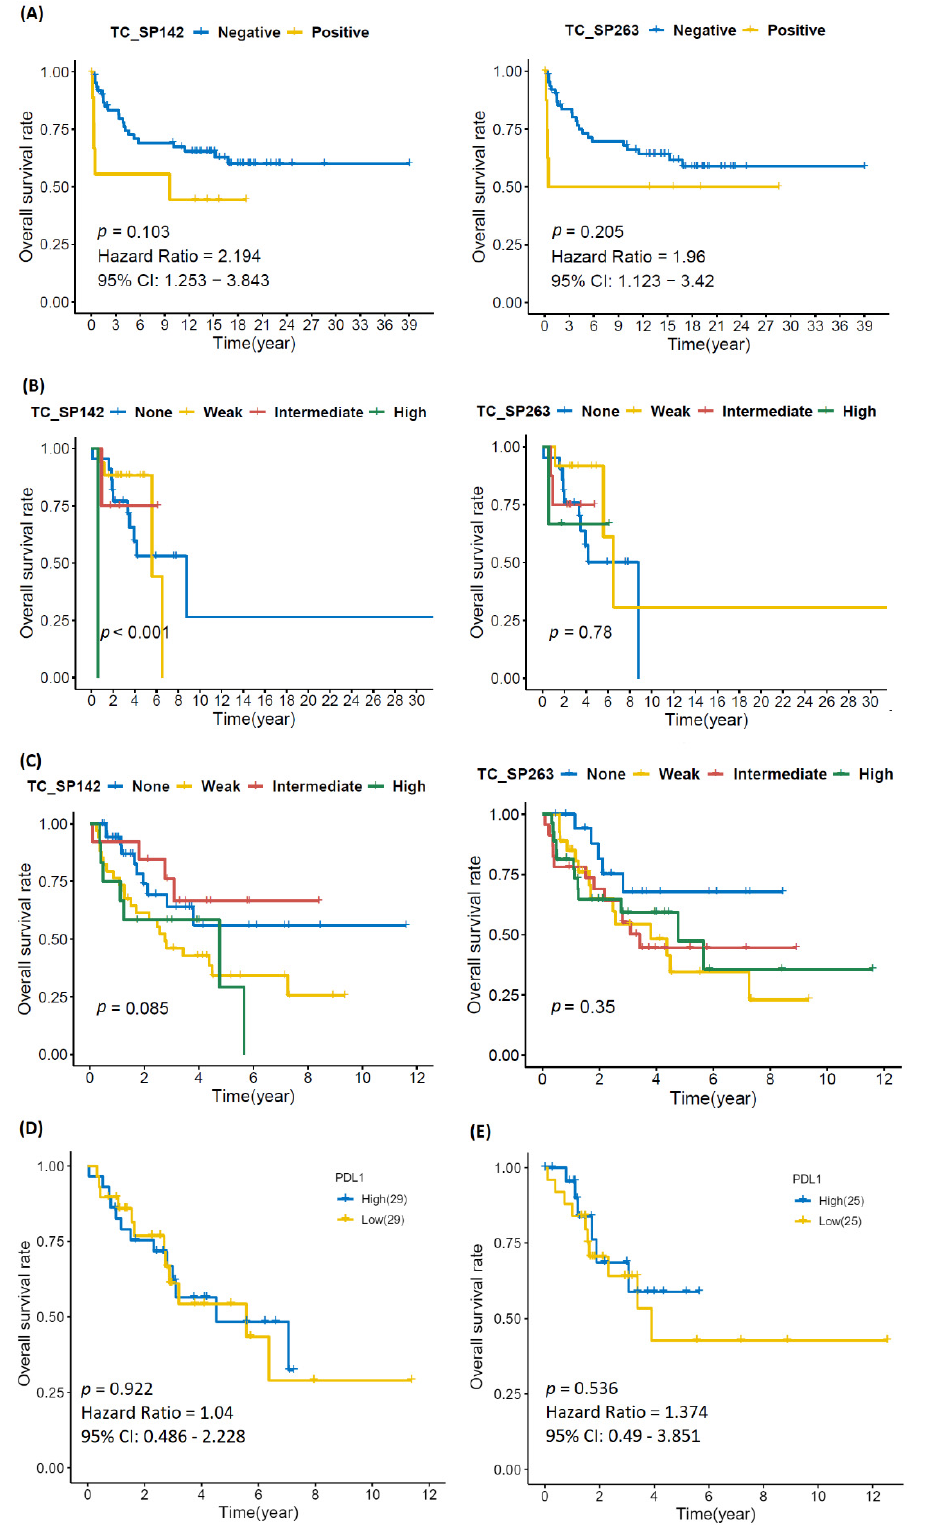
Figure 3. Kaplan–Meier curves depicting overall survival in ( A ) chondrosarcoma, ( B ) liposarcoma and ( C ) undifferentiated pleomorphic sarcoma in relation to PD-L1 immunoreactivity in tumor cells, as well as data from the Cancer Genome Atlas for ( D ) LS and ( E ) UPS, showing no significant impact of PD-L1 status on overall survival. Kaplan–Meier survival analysis was performed by log-rank